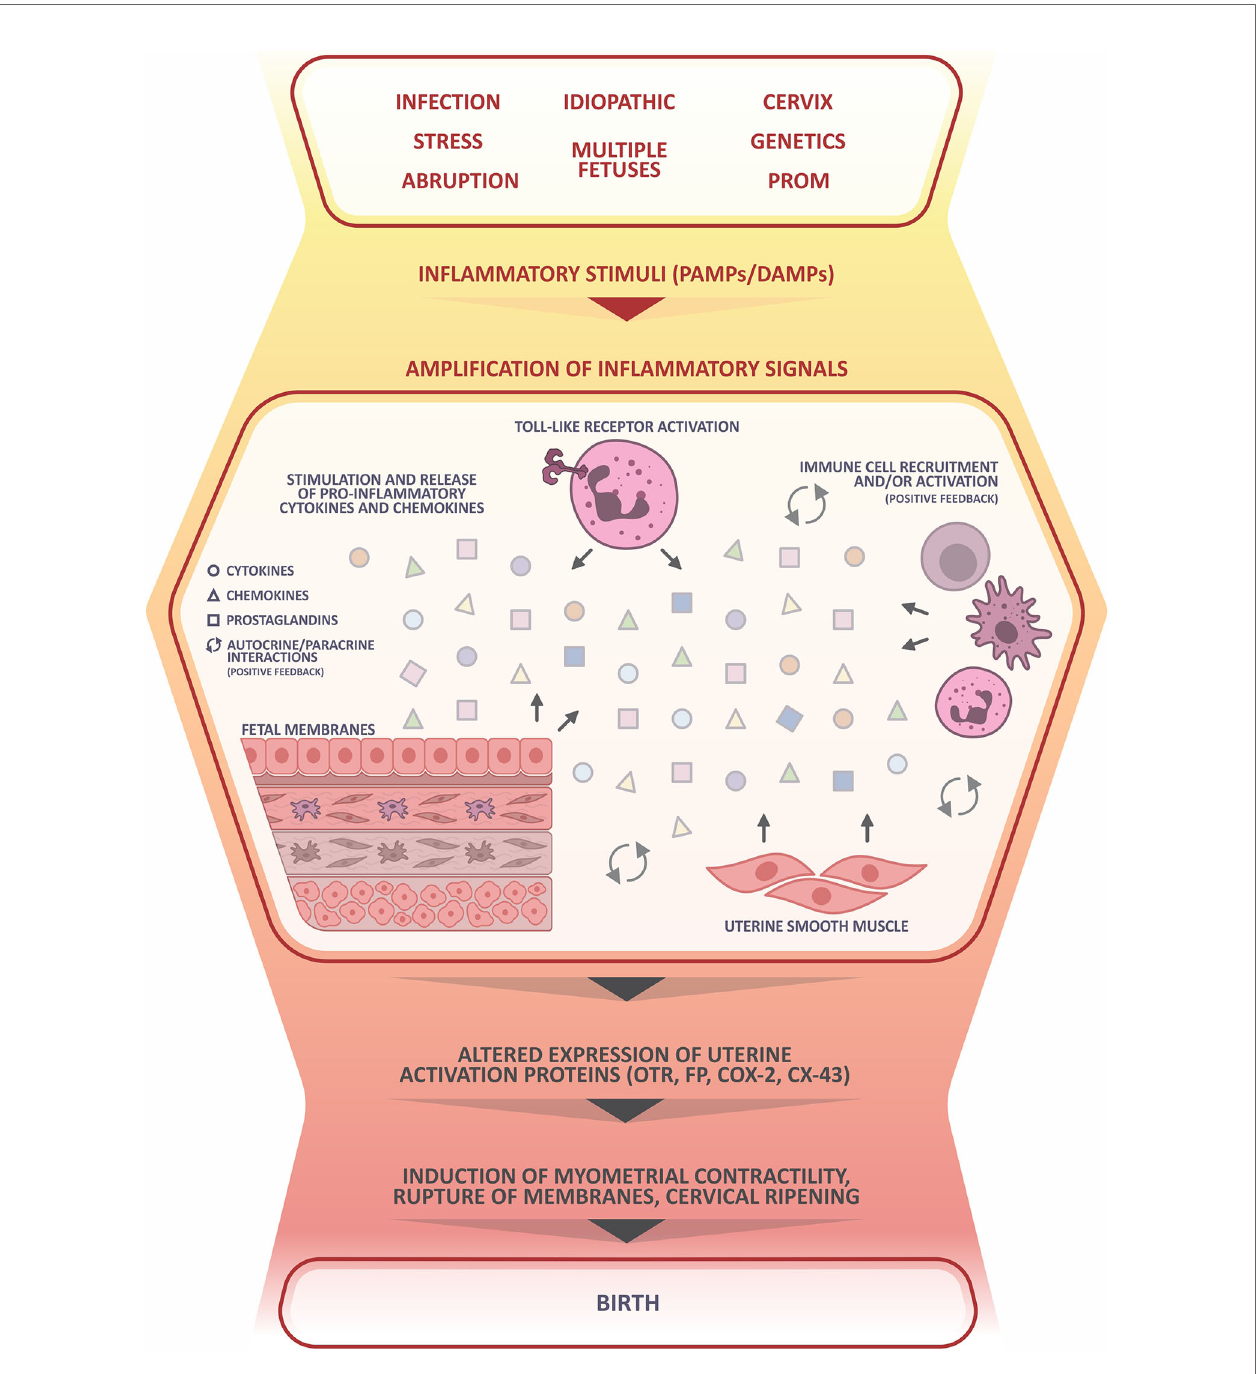
FIGURE 1 | In fl ammatory roadmap leading to birth and preterm birth. PAMPs or DAMPs are stimulated by infection, stress, or other initiators. They activate toll-like receptors (TLRs), which, in turn induce in fl ammasome assembly and stimulation of pro-in fl ammatory cytokines and chemokines. These pro-in fl ammatory agents stimulate leukocyte activation so that they in fi ltrate the uterus and release more cytokines and chemokines, thereby recruiting and activating more leukocytes in a positive feedback loop. These mediators also act on adjacent intrauterine tissues; in response, those tissues release additional in fl ammatory mediators. The ampli fi cation of in fl ammatory signals promotes altered expression of uterine activation proteins including COX-2, CX-43, FP, and OTR, among many others. Together, these changes comprise the transition of the uterus of pregnancy into the active and contractile uterus of delivery, stimulating the physiological events of delivery. PROM, premature rupture of membranes; PAMP, pathogen-associated molecular pattern; DAMP, damage-associated molecular pattern; OTR, oxytocin receptor; FP, Prostaglandin F 2 a receptor; COX-2, cyclooxygenase-2; CX-43, connexin 43. Portions of this fi gure were created using BioRender.com.